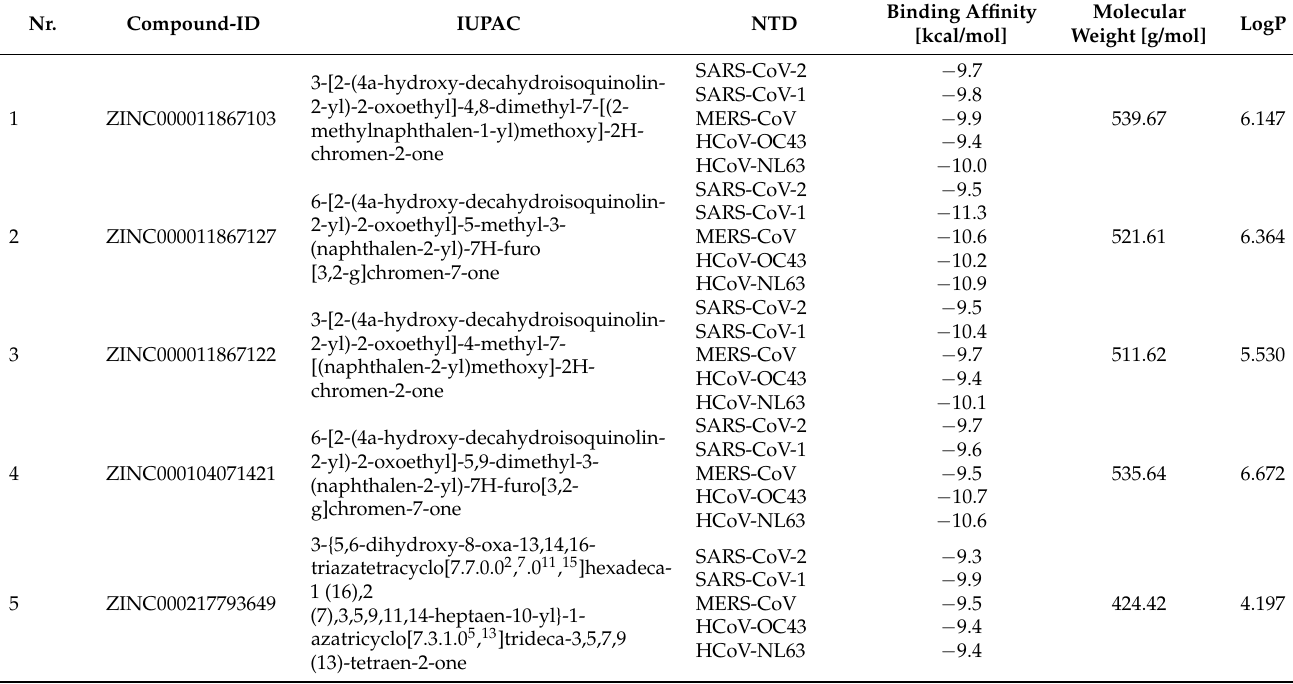
Figure 3. Chemical structures of selected candidate molecules from virtual docking used for subse- quent in vitro studies. Table 2. Properties and docking results of compounds selected from virtual drug